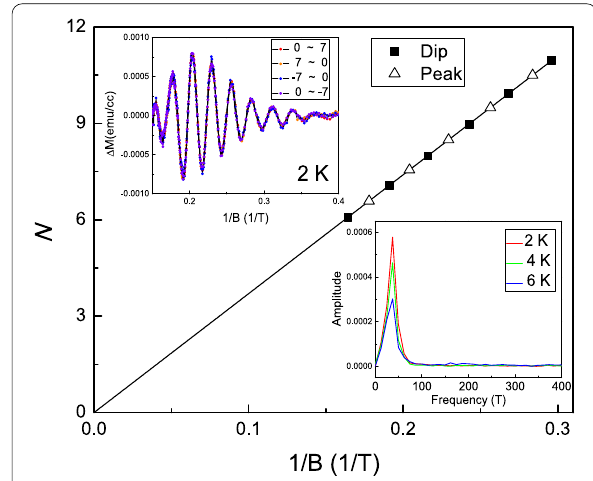
Fig. 6 Top‑left inset shows the extracted magnetization as a function of inverse magnetic fields at different sweeping directions. It shows periodic oscillations. Bottom‑right inset shows the fast Fourier transform of the magnetization oscillation. It shows single oscillation peak at measured temperatures. The Landau‑level fan diagram. The intercept is 0 which indicates the oscillation originates from the 2D Fermi